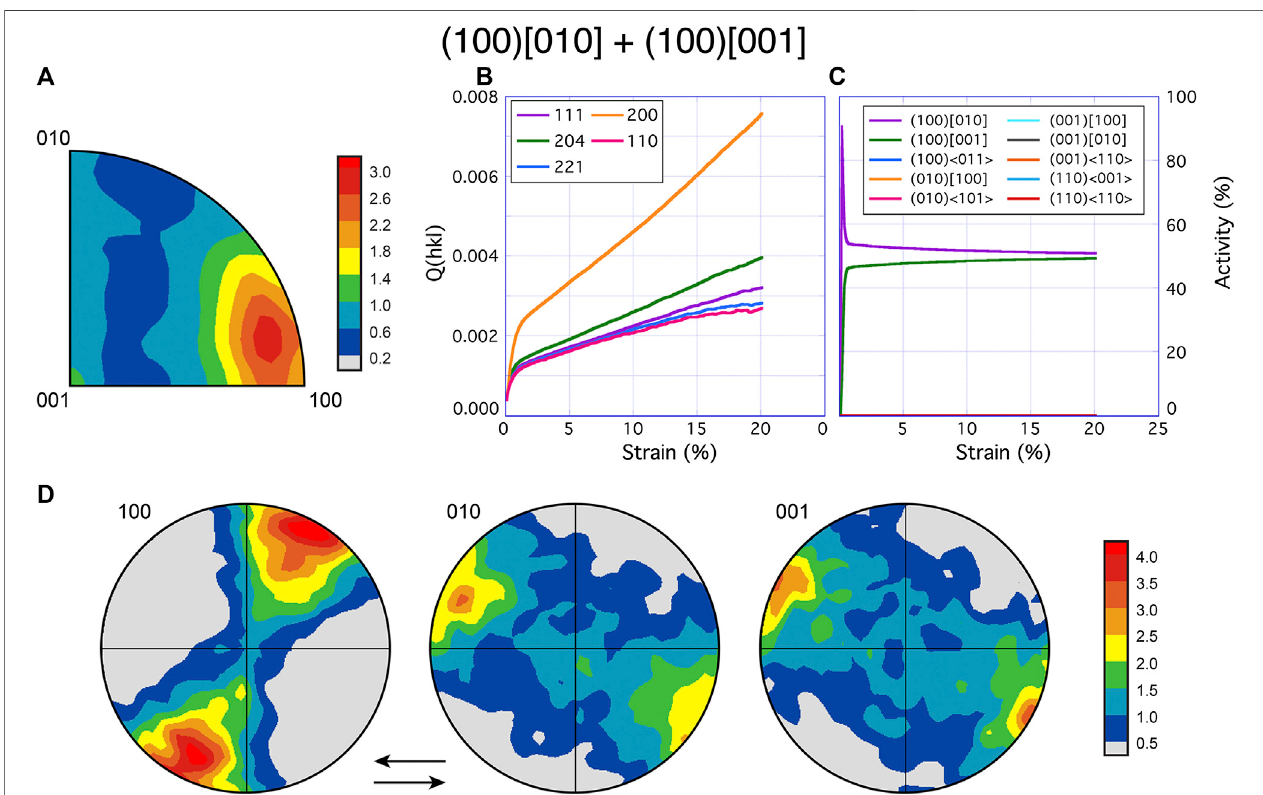
FIGURE 5 | Model results of bridgmanite for the slip system pair (100)[010] and (100)[001]. The results of elasto-viscoplastic self-consistent (EVPSC) modeling show (A) texture with color scales of the inverse pole fi gure (compression direction) given in multiples of random distribution. Q ( hkl ) and slip system activity are shown in plot (B) and (C) , respectively. Pole fi gures (D) from VPSC models were simulated with the same critical resolved shear stress values as the EVPSC model. Shear orientation is top to the left, shown by the arrows. The activity of all but (100)[010] and (100)[001] is < 1% at all conditions.